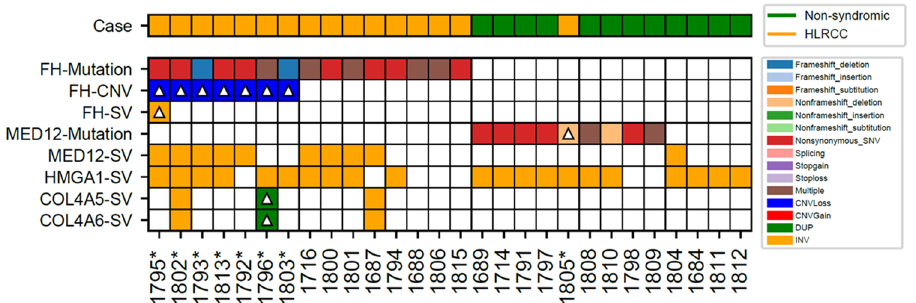
Figure 1. Mutation, Copy Number Variation and Structural Variant (SV) Analysis of Fumarate Hydratase ( FH ) and in Genes Associated with Uterine Leiomyoma Development. Heatmap details single nucleotide variants (SNVs), insertion/ deletion, copy number variation (CNV) events as well as cases harboring multiple variants in FH or uterine leiomyoma driver genes; Mediator Complex Subunit 12 ( MED12 ), High Mobility Group AT-Hook 1 ( HMGA1 ), Collagen Type IV Alpha 5 Chain ( COL4A5 ) and collagen type IV alpha 6 chain ( COL4A6 ) 10